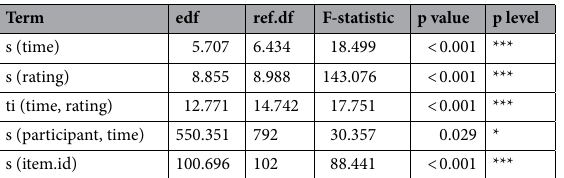
Table 5. Summary output for the basic GAMM modelling participants’ pupil sizes in response to semantic anomalies.